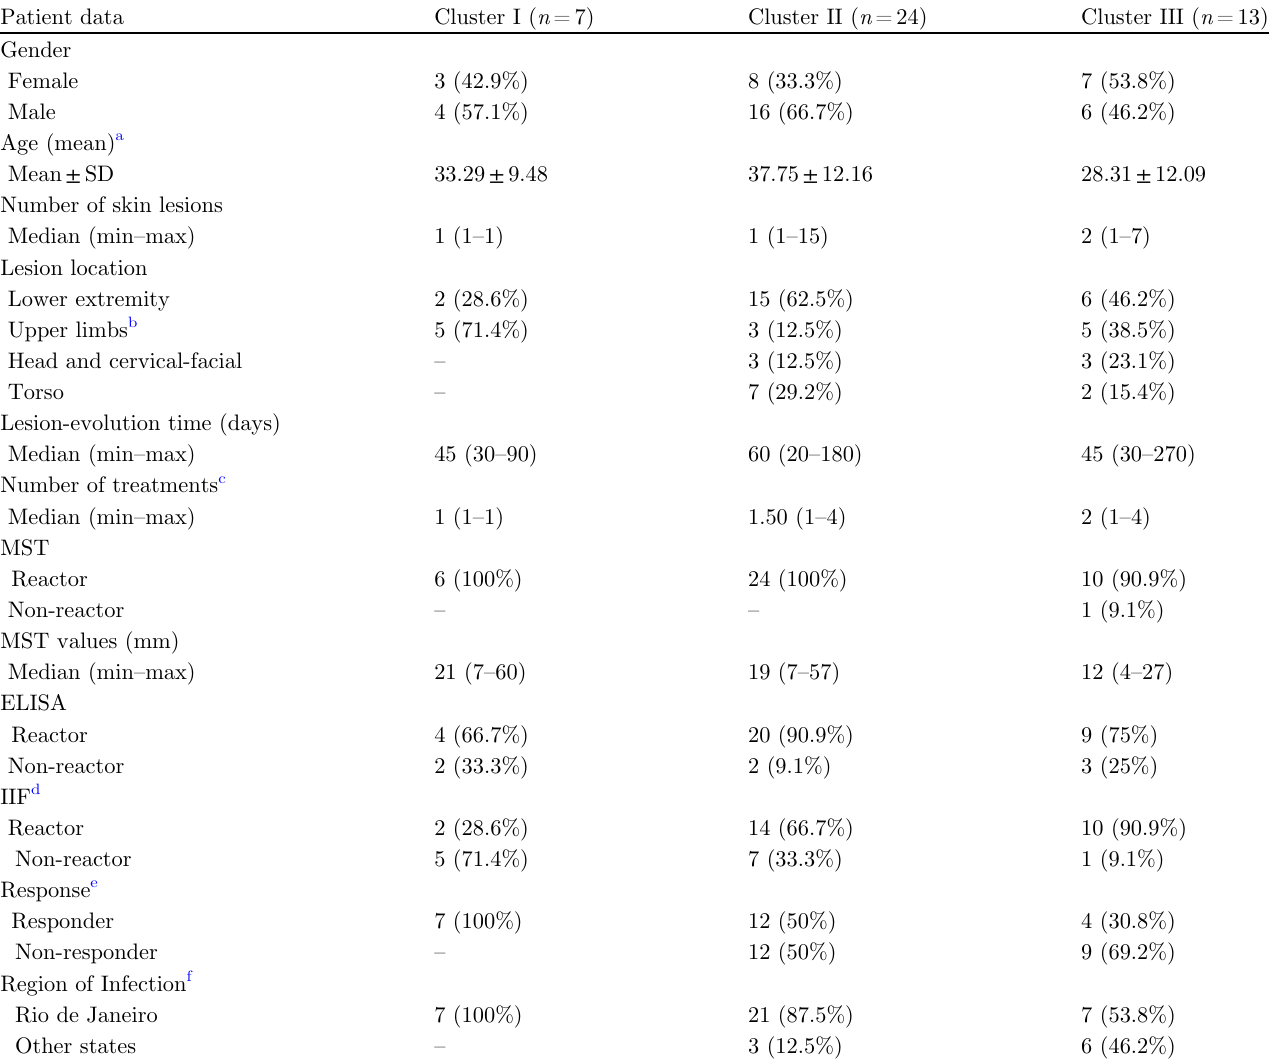
Table 3. Clinical and laboratory data of the 44patients with cutaneous leishmaniasis studied. Intra- and inter-clusters division (numerical and categorical